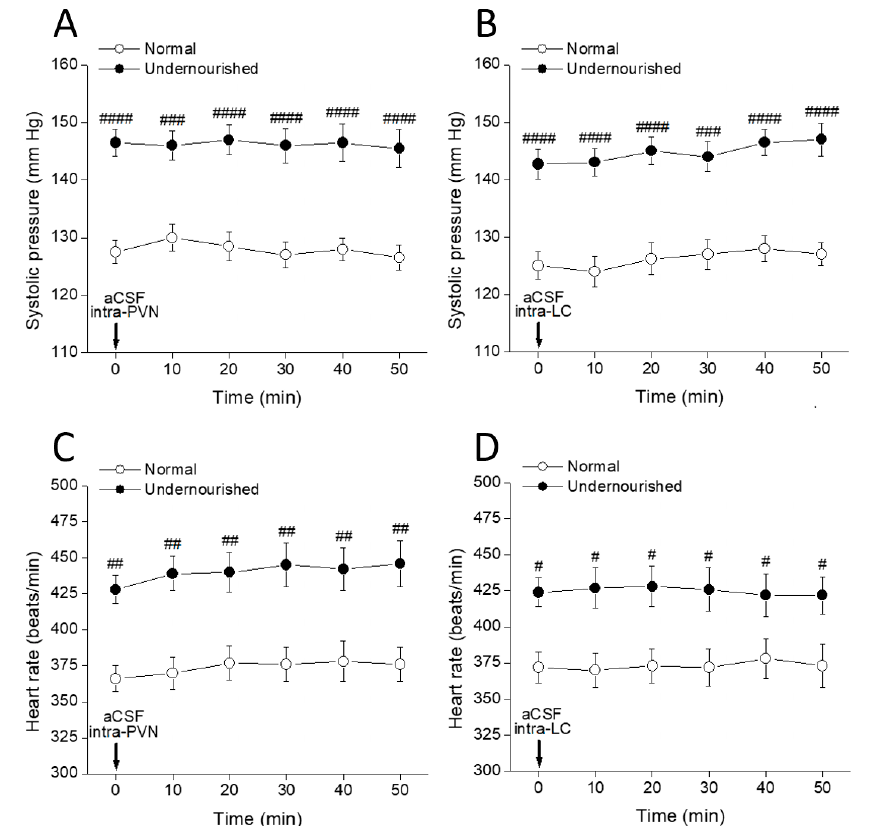
Figure 1. Time-course of changes in systolic pressure ( A , B ) and heart rate ( C , D ) of normal and prenatally undernourished rats after intra-PVN or intra-LC microinjection (arrow at time 0 min) of artificial cerebrospinal fluid (aCSF). Values are means ± SEM, n = six rats in each group. Two-way repeated measures ANOVA was used to identify the nutritional treatment and/or the time elapsed after aCSF microinjection as significant factors in the effect examined (( A ): for the effect of intra-PVN aCSF on systolic pressure, F nutrition(1, 10) = 161.8 and F time(5, 50) = 0.1753; ( B ): for the effect of intra-LC aCSF on systolic pressure, F nutrition(1, 10) = 61.07 and F time(5, 50) = 0.4028; ( C ): for the effect of intra-PVN aCSF on heart rate, F nutrition(1, 10) = 224.6 and F time(5, 50) = 0.5895; ( D ): for the effect of intra-LC aCSF on heart rate, F nutrition(1, 10) = 33.68 and F time(5, 50) = 0.0164). Dunnett’s multiple comparisons test detected no significant intragroup differences at any time after aCSF (referred to the pre-aCSF control at time = 0 min), while Bonferroni’s multiple comparisons test detected significant intergroup differences at all times between normal and undernourished animals ( # p < 0.05, ## p < 0.01, ### p < 0.001, #### p < 0.0001).